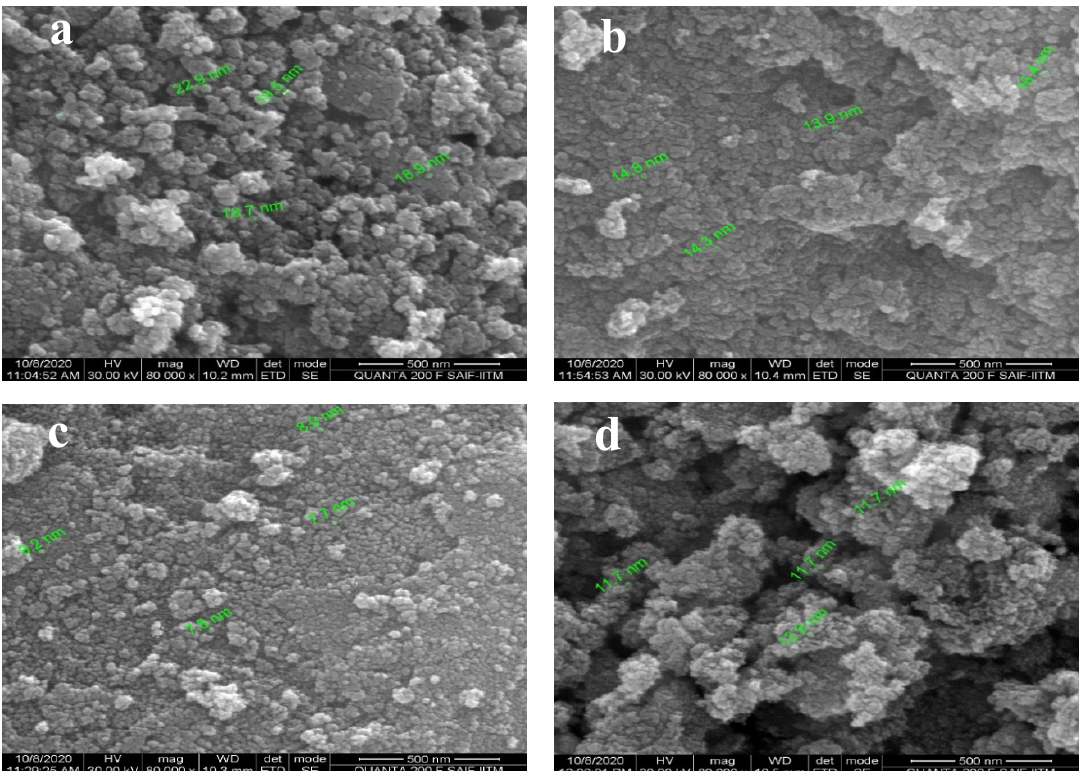
Figure 6. FESEM image showing the particle size of ( a ) SnO 2 , ( b ) SnO 2 with 0.1% Pd, ( c ) SnO 2 with 0.2% Pd, ( d ) SnO 2 with 0.3% Pd.